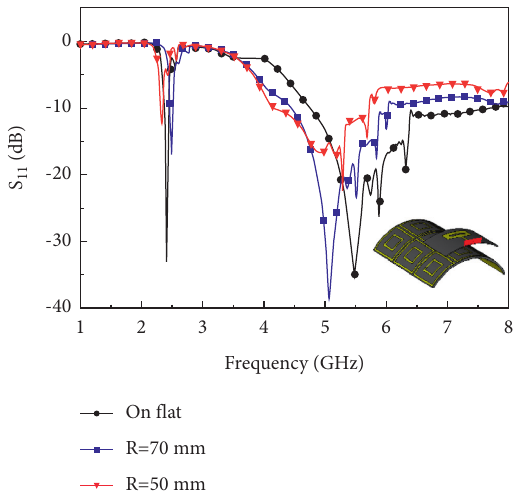
Figure 7: S 11 of the proposed antenna system when bent under different